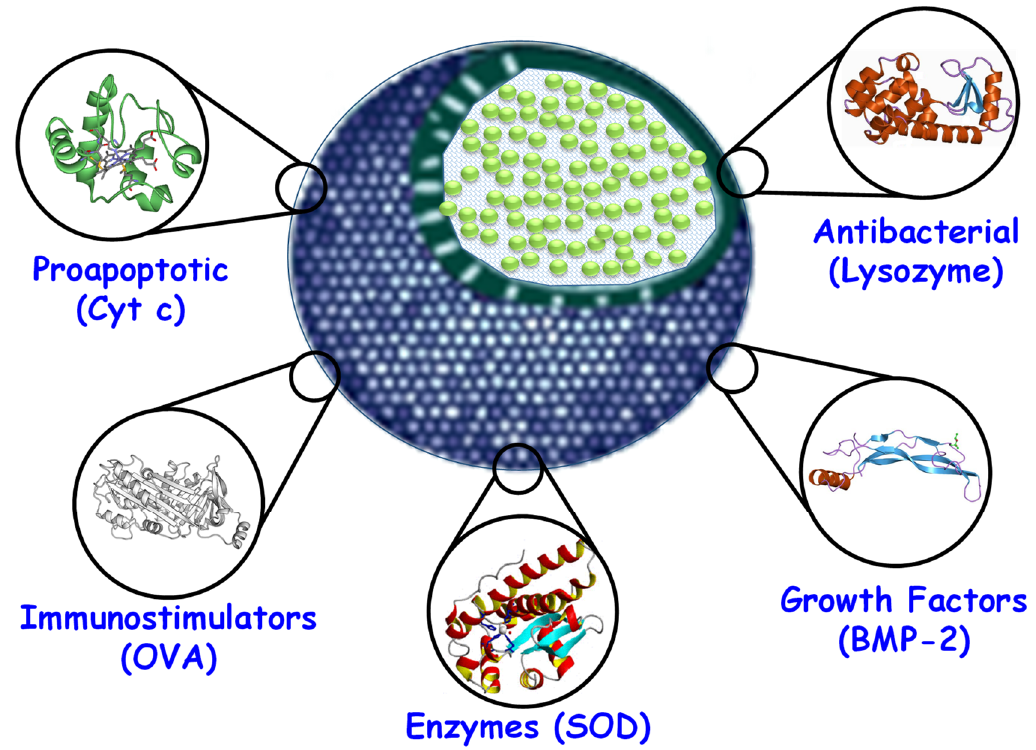
Figure 3. Roles and examples of typical therapeutic proteins delivered with silica-based nanosystems.